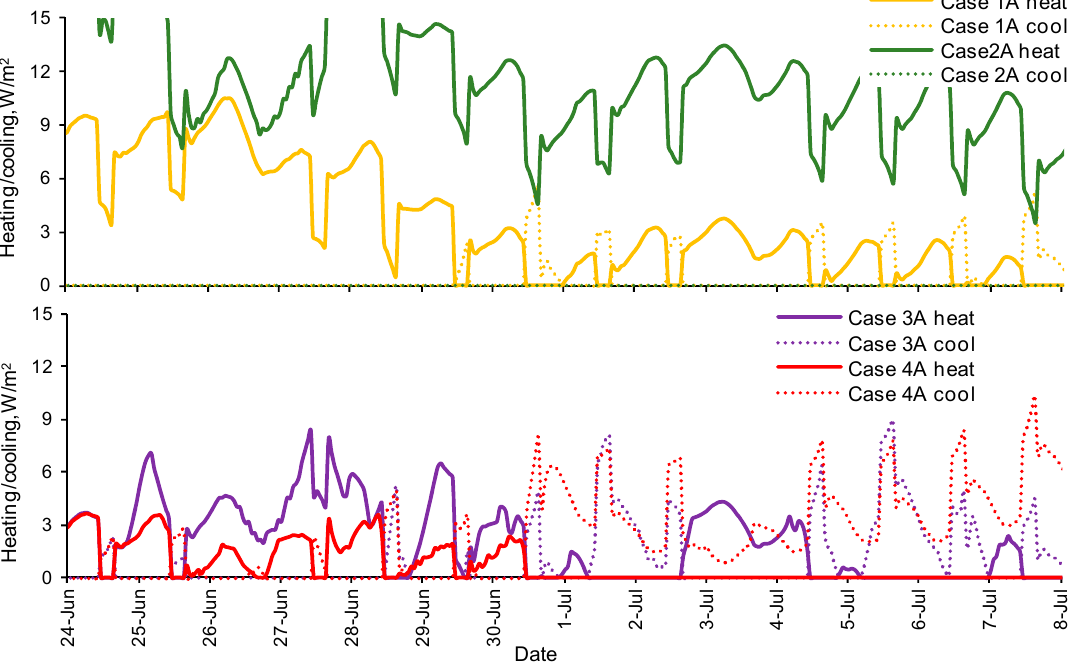
Figure 8. Variation in the heating and cooling demand in the ethnography hall over two summer weeks.